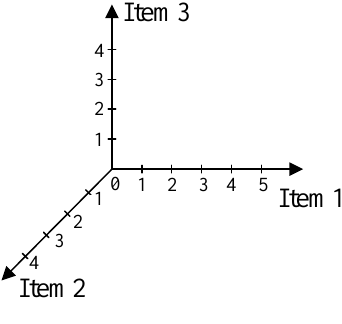
Figure 1. 3-dimension data